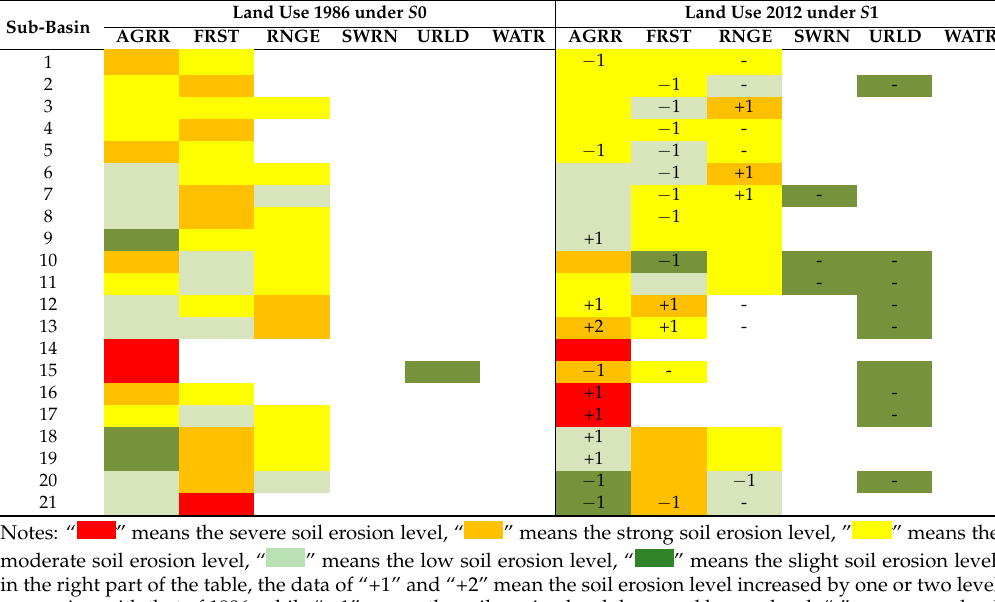
decreased by one level. “-” means new land use types with no comparison.